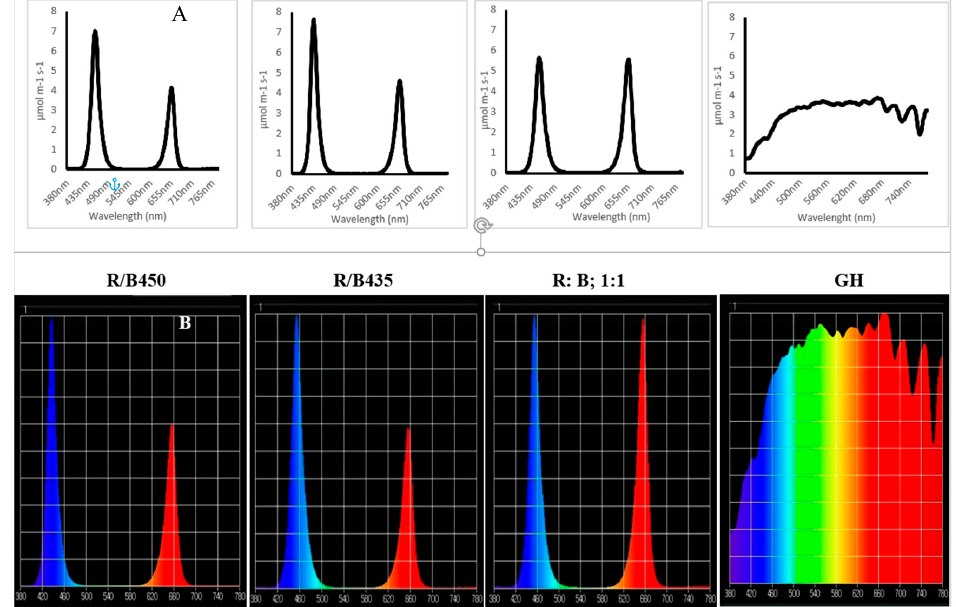
Figure 1. Spectra of the lighting treatments used as measured by a UPRtek spectrophotometer: ( A ) the radiant density of the light spectrum intensity and ( B ) the relative light intensity.